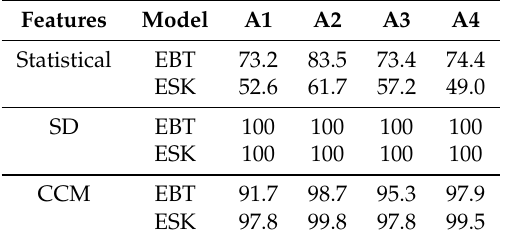
Table 4. Percent accuracy for each of features types and models calculated over the dataset of valve faults in